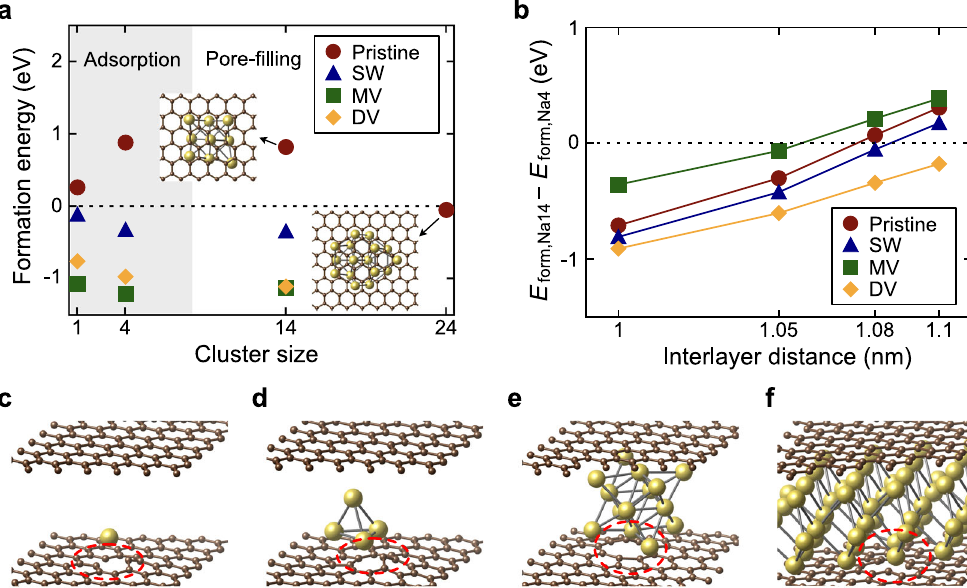
Fig. 5 Pore- fi lling mechanism in micropore and correlated formation energy. a The formation energy of Na cluster inside slit-shaped graphene pore according to the cluster size. For the small cluster in shade region, adsorption energy is displayed. b The difference of formation energy between Na 14 cluster inside the pore and Na 4 on the graphene as a function of interlayer distance. c – f Structures of Na- storing slit-shaped graphene pore with